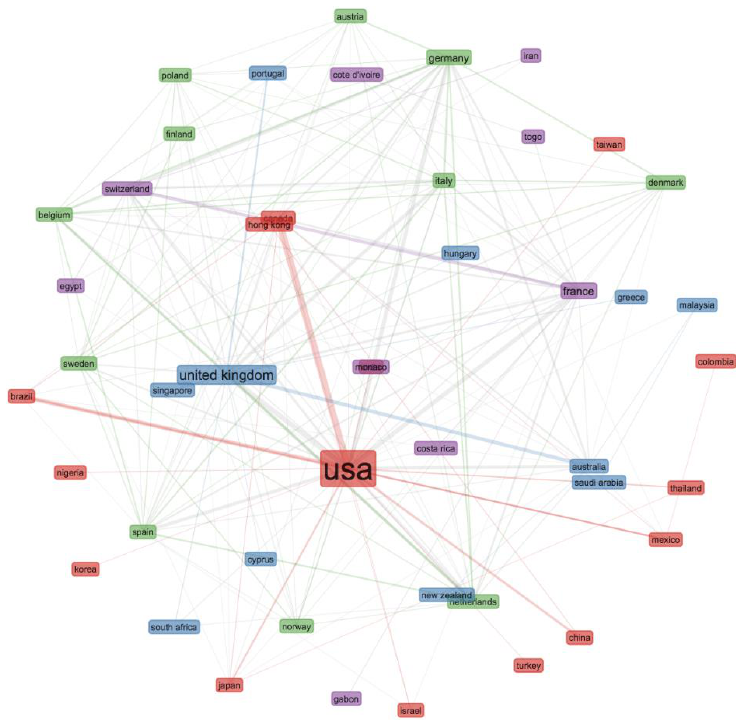
Figure 2. Collaboration network. The size of the rectangle is proportional to the number of publica- tions; the thickness of line represents the strength of collaborations; the colors represent the collab- oration clusters.